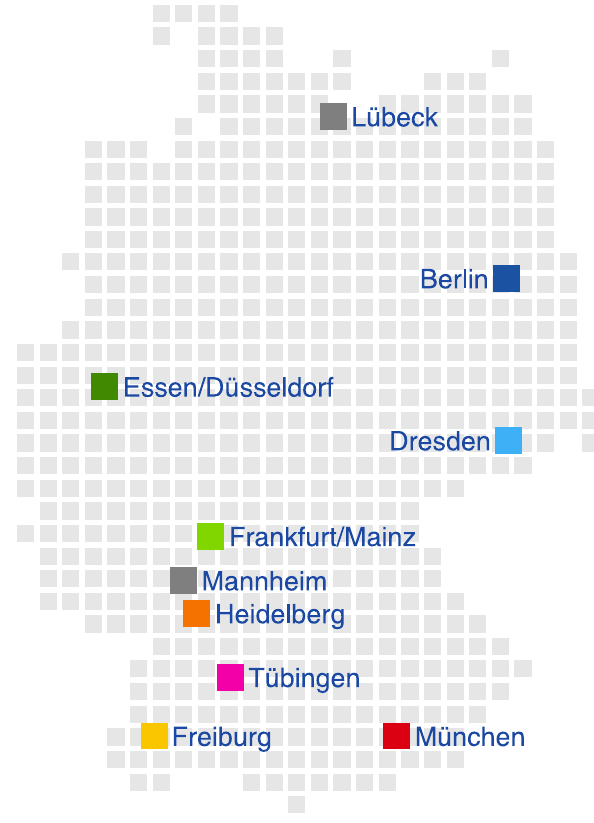
Figure 1: Map of the EXLIQUID sites. Depicted are the eight DKTK sites contributing to EXLIQUID (colored squares) and the two associated sites (gray